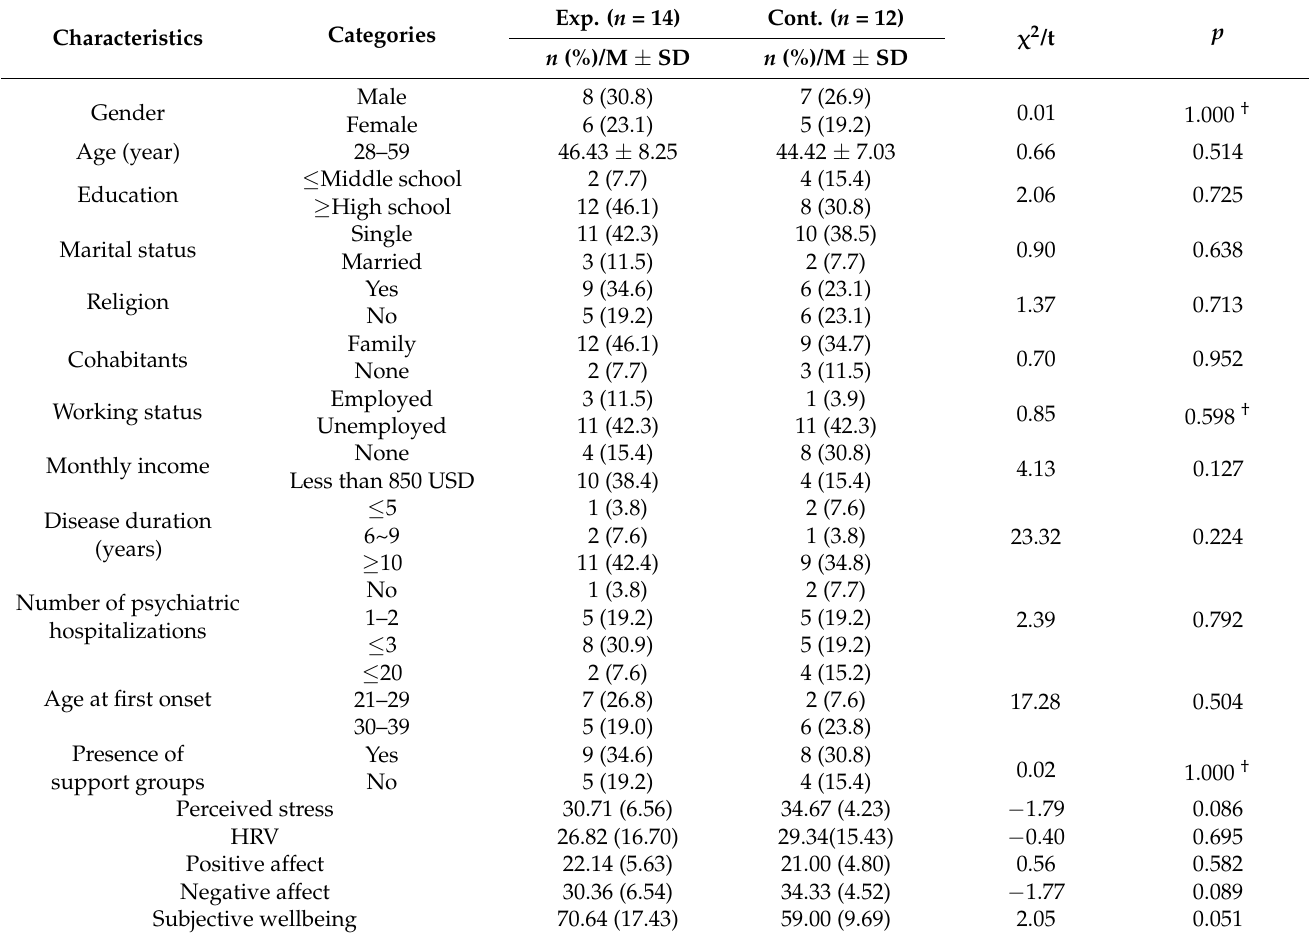
Table 2. Baseline characteristics and between-group differences ( N =